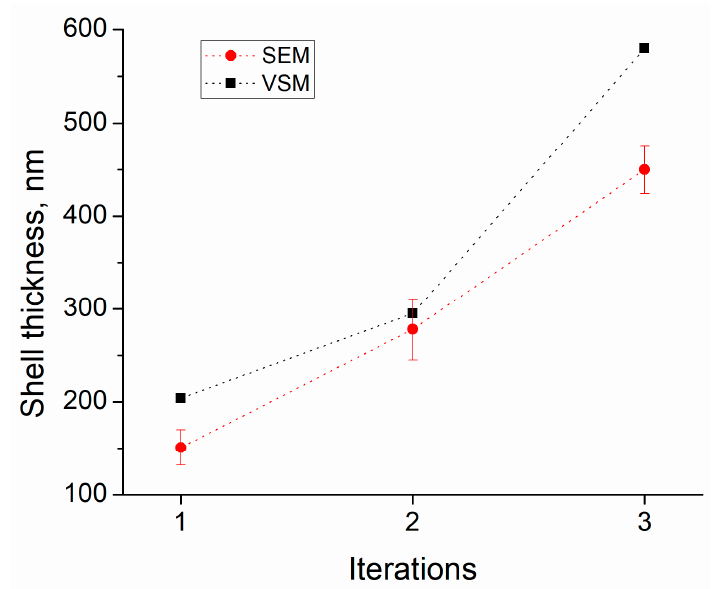
Figure 9. Comparison of the SEM and VSM methods.